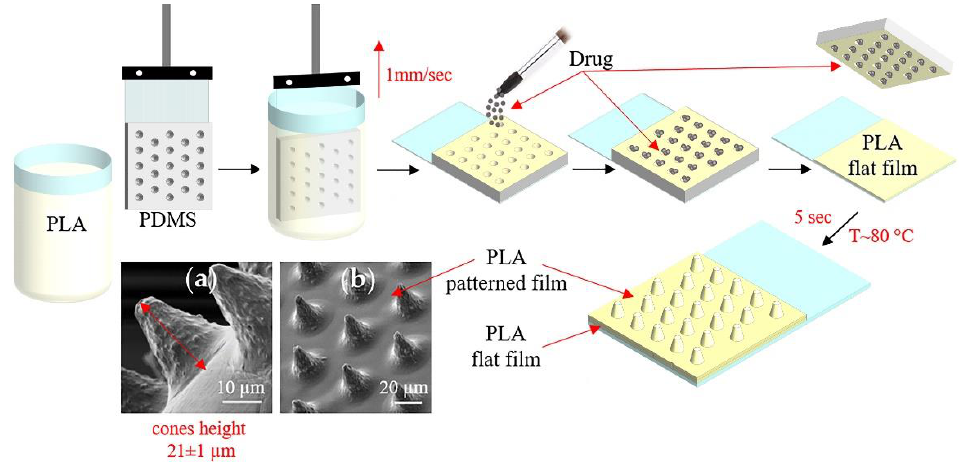
Figure 1. The scheme of fabrication microchamber arrays containing ceftriaxone. SEM images of the outer surface of microchamber arrays based on PLA ( a , b ).